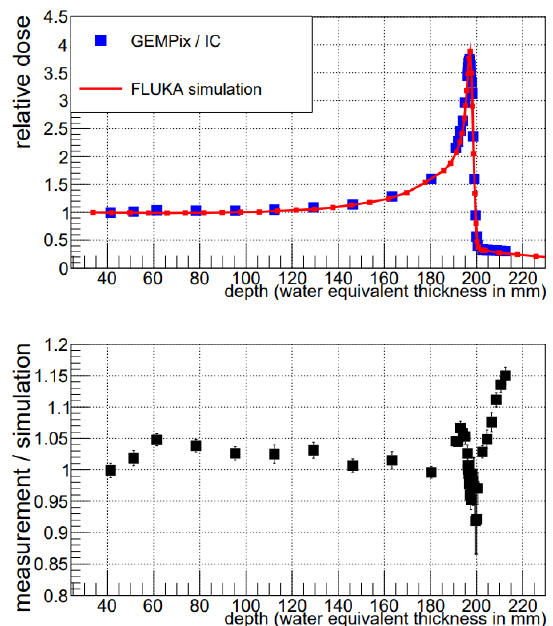
Figure 9. The upper plot shows the Bragg curve for 200 mm range in water, measured by the GEMPix and calculated with FLUKA. The lower plot shows the ratio of the experimental data to the FLUKA curve. The data points match the simulation within ±15%.